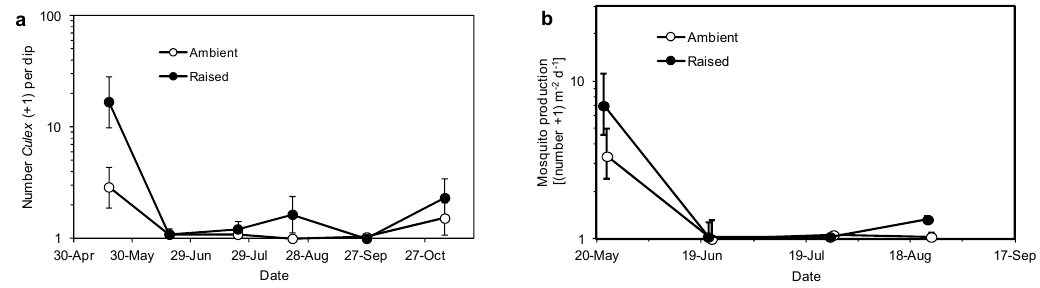
Figure 3. ( a ) Abundance of immature mosquitoes in 350 ‐ mL dipper samples (backtransformed mean ± 95% CI) and ( b ) adult mosquito production (backtransformed mean ± 95% CI) from two hydroperiod treatments in 0.09 ‐ ha wetlands from May through November 2013.